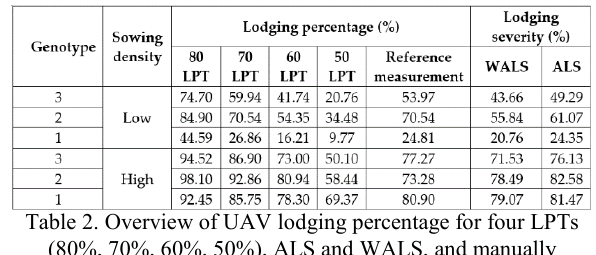
Table 2. Overview of UAV lodging percentage for four LPTs (80%, 70%, 60%, 50%), ALS and WALS, and manually determined lodging percentage reference data for different sowing densities and genotypes 75 DAS (n = 36). LPT: lodging percentage threshold; WALS: weighted average lodging severity; ALS: average lodging